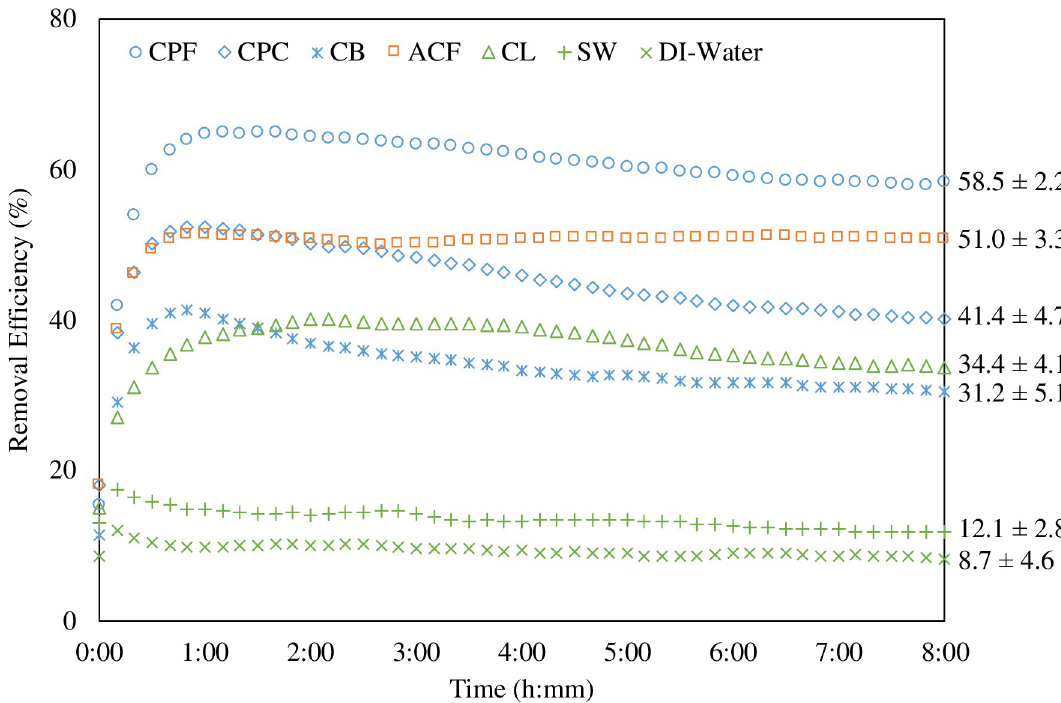
Fig 4. The ozone removal efficiency of the materials under test. Every data point represents a 10-minute average removal efficiency. The data point at 0:00 is an average from 0:00 to 0:10 and the data point at 8:00 is an average from 8:00 to 8:10. The ozone removal efficiency labeled on the right is the average removal efficiency from 6:00 to